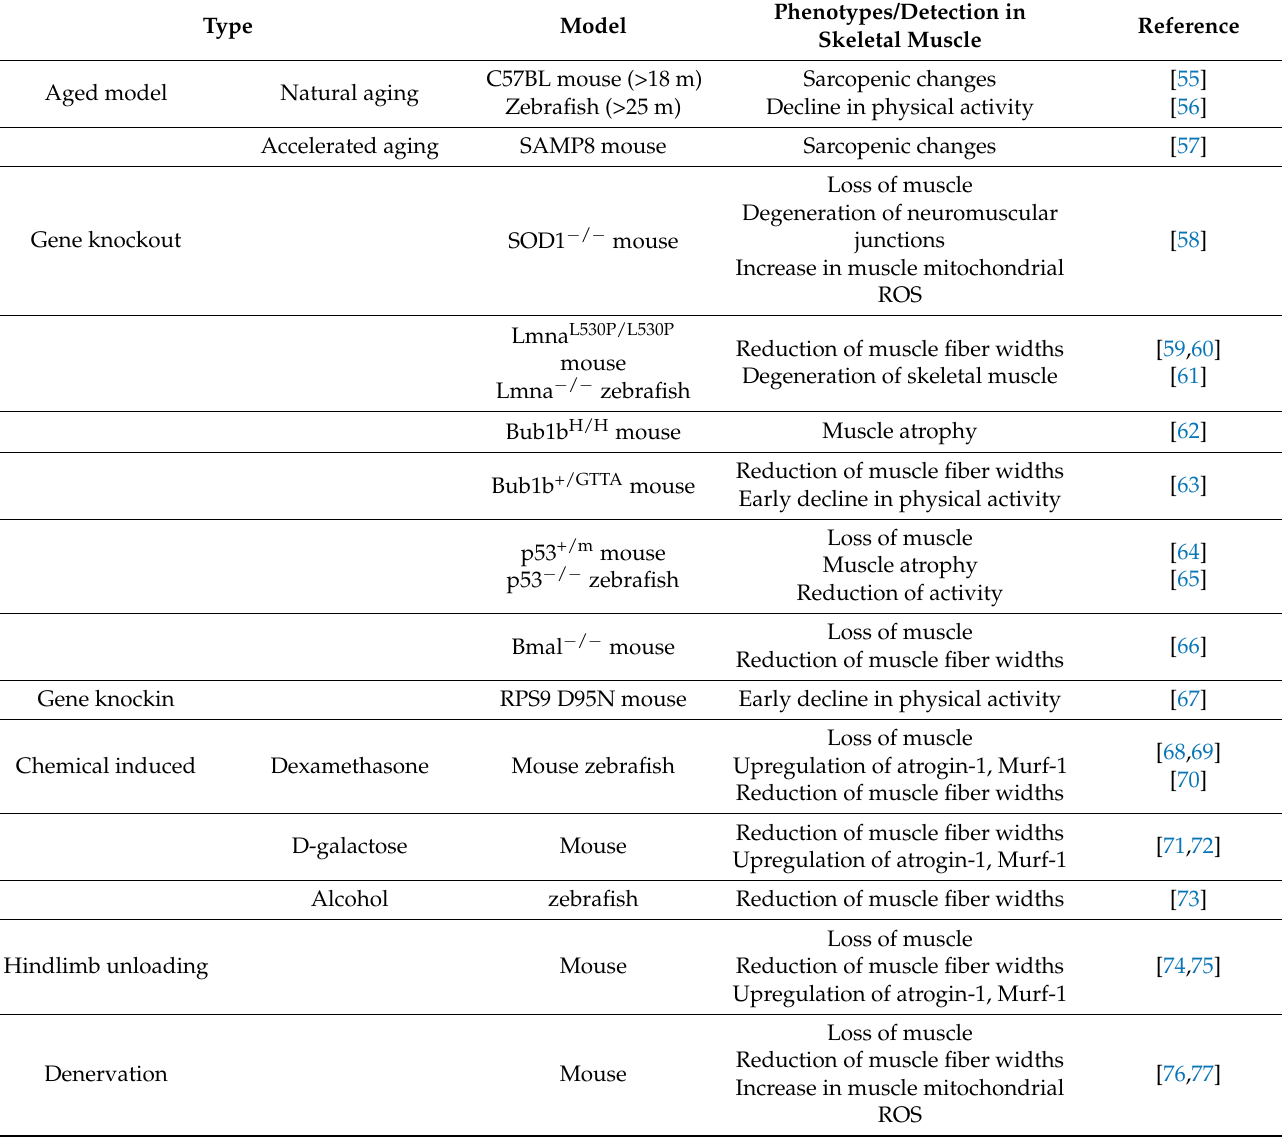
Table 1. Rodent and zebrafish models for skeletal muscle